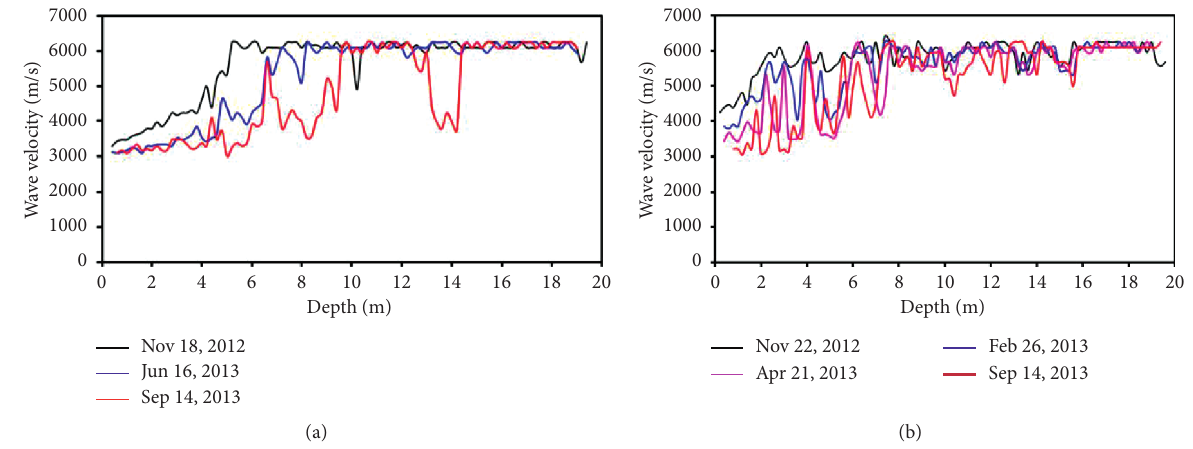
Figure 13: Typical test results of acoustic wave curves measured in the upstream sidewall of the main powerhouse during excavation (a) in section of 0+041.3m (elevation of 1718.00m) and (b) in section of 0 +008.8m (elevation of